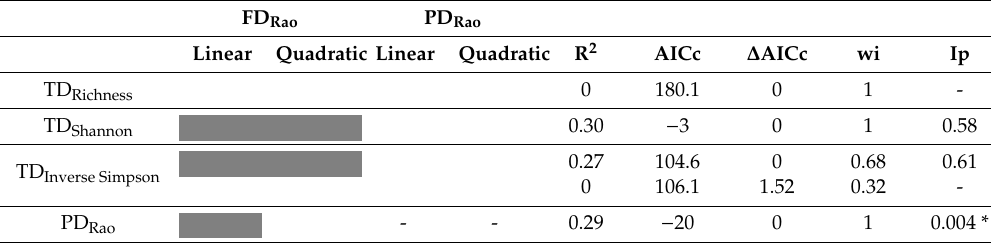
Table 1. Ranking of linear models analyzing the relationship between TD, FD, and PD following an AIC-based model selection procedure. For each community diversity metric, the best model (lowest AICc value) is presented in the first row followed by the rest of models with ∆ AICc ≤ 2. Grey cells indicate predictors included in a particular model. Only significant relationships ( p < 0.05) are shown. R 2 adj, percentage of variance explained by a particular model; AICc, relative goodness of fit; ∆ AICc, AIC di ff erences; wi, Akaike weight; Ip, Moran index p -value. FD Rao PD Rao Linear Quadratic Linear Quadratic R 2